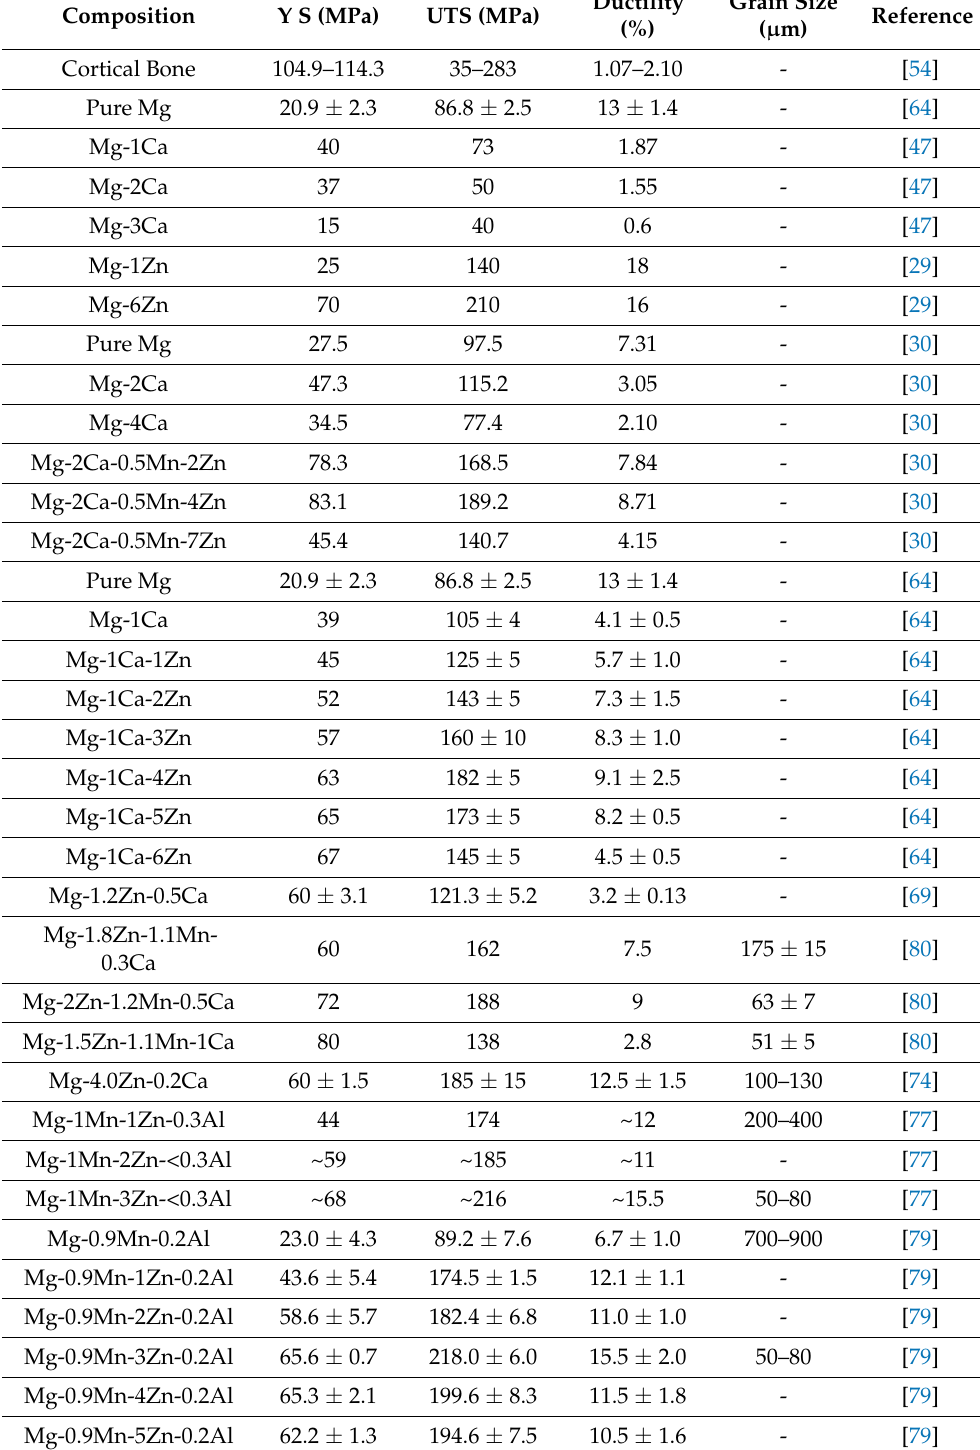
Table 1. Examples of the mechanical properties and grain size of Mg-based alloys.